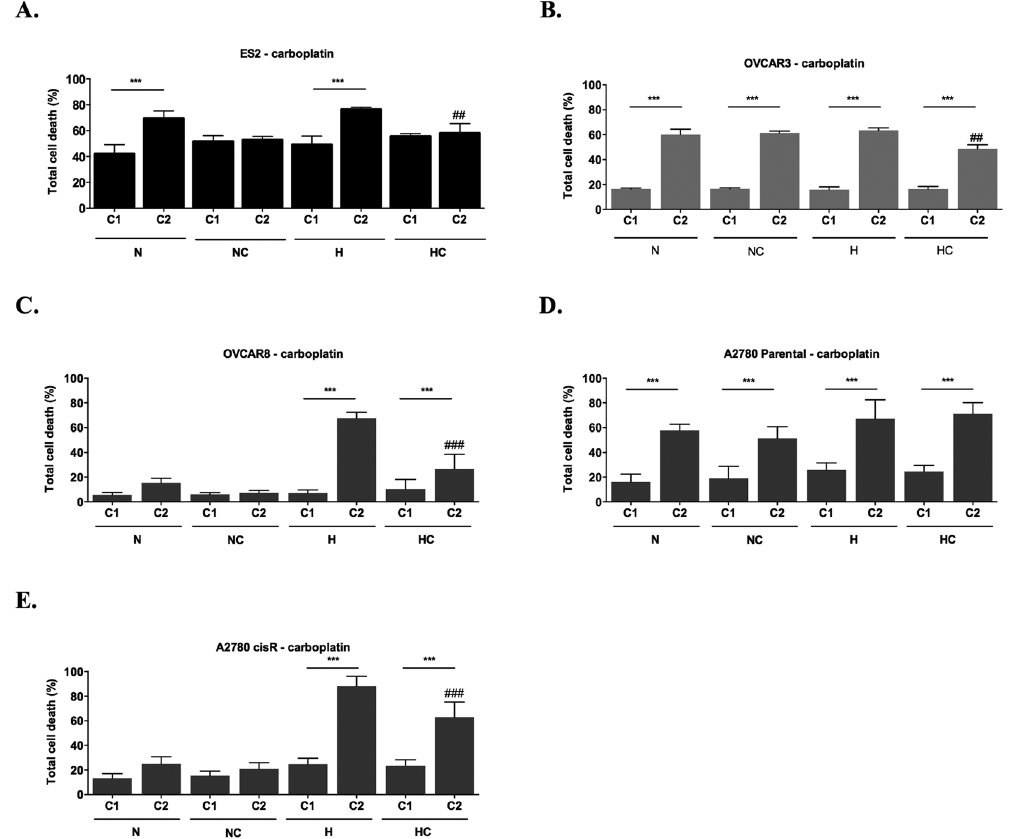
Figure 5. Cysteine and hypoxia (H) have a role on the response to carboplatin by ovarian cancer cells. Total cell death in the first (C1) and in the second (C2) cycles of treatments in the presence of Carboplatin for ( A ) ES2, ( B ) OVCAR3, ( C ) OVCAR8, ( D ) A2780 parental cells and ( E ) A2780 cisR cells. N – Normoxia; NC – Normoxia supplemented with cysteine; H – Hypoxia; HC – Hypoxia supplemented with cysteine. Results are shown as mean ± SD. Cardinals represent statistical significance among hypoxia with and without cysteine supplementation within the same cycle of treatments. * p < 0.05, ** p < 0.01, *** p < 0.001 (One-way ANOVA with post hoc Tukey